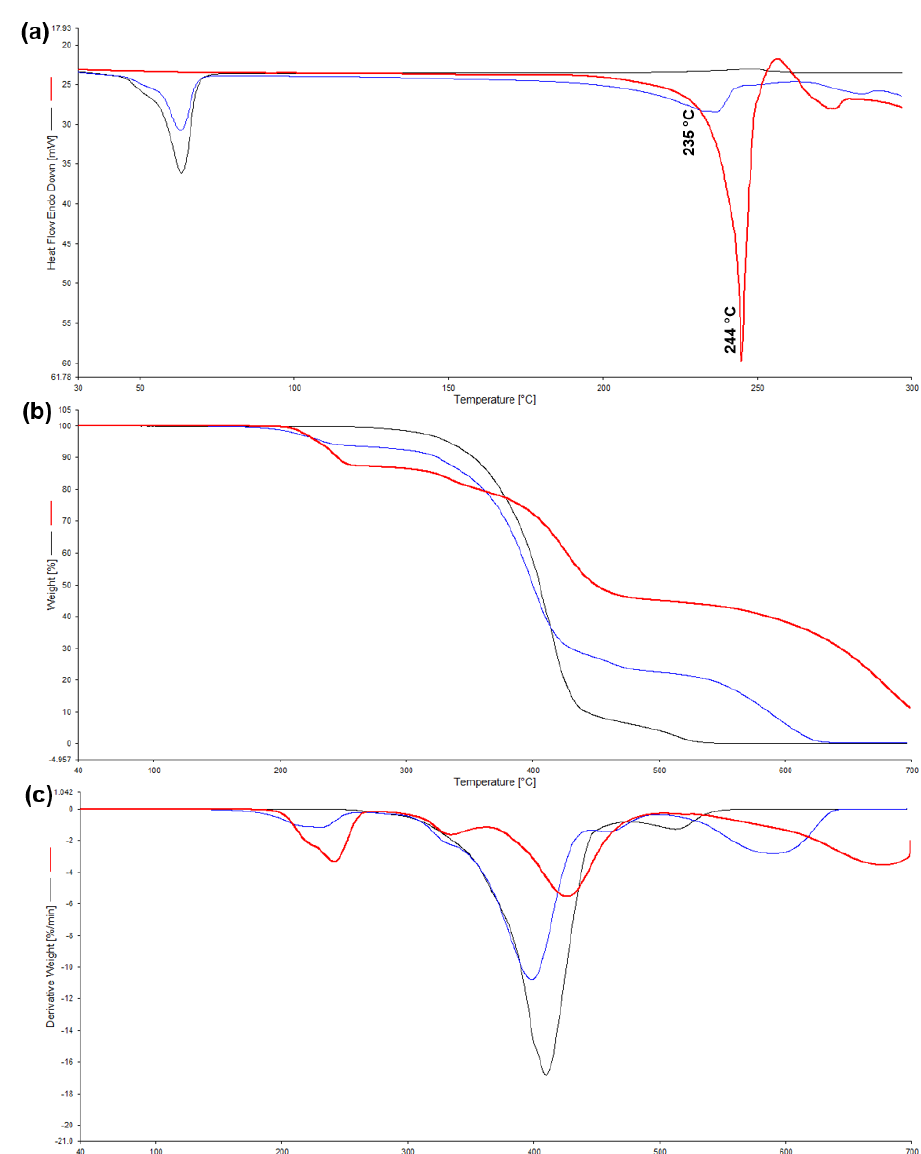
Figure 5. Thermal behaviour of PCL—DSC ( a ), TGA ( b ), and DTG ( c ) at a heating rate of 10 ◦ C min − 1 . Fen (red), neat polymer (black), and physical mixture (blue).